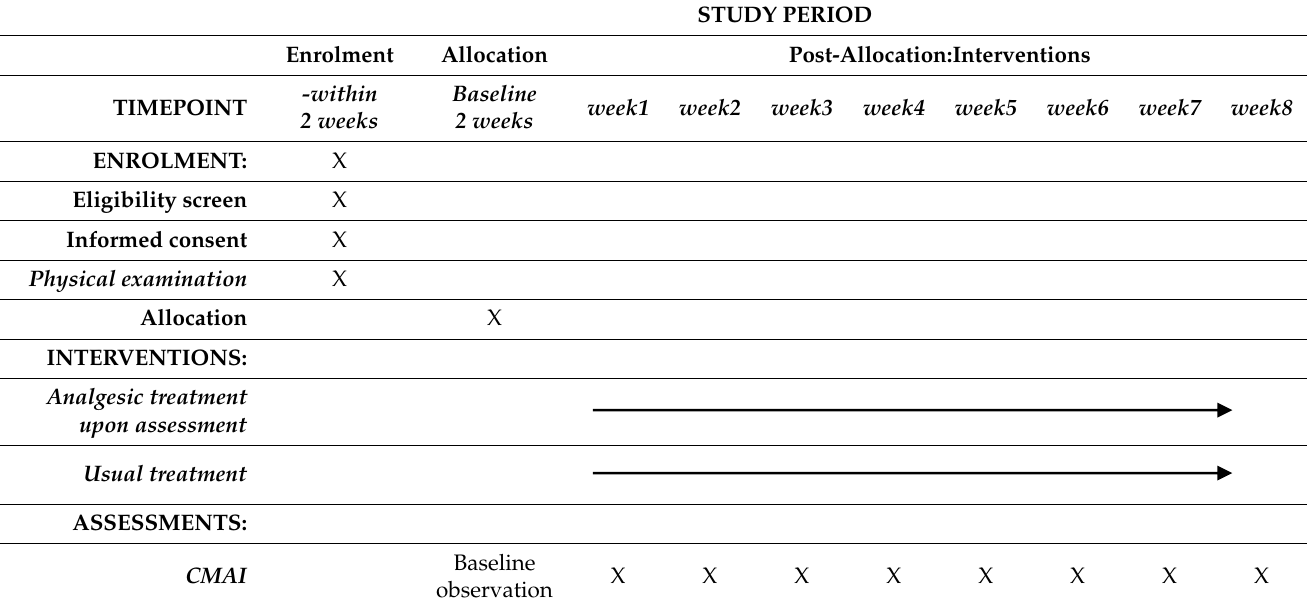
Table 1. Timeline of pain assessment. Table 2. Table 2. Timeline of agitation assessment.